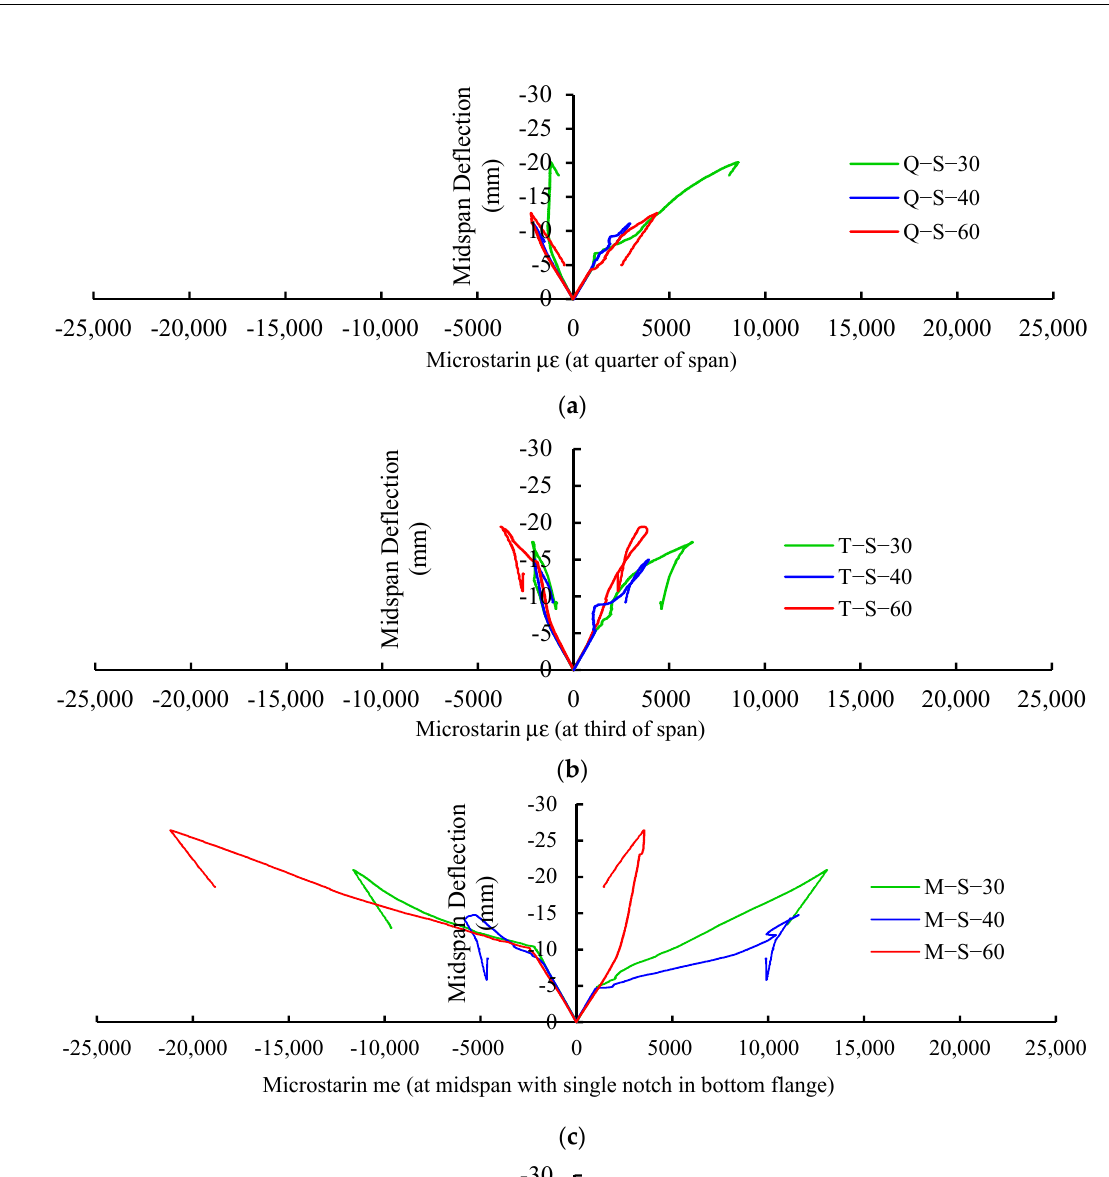
Microstarin me (at midspan with single notch in bottom flange)